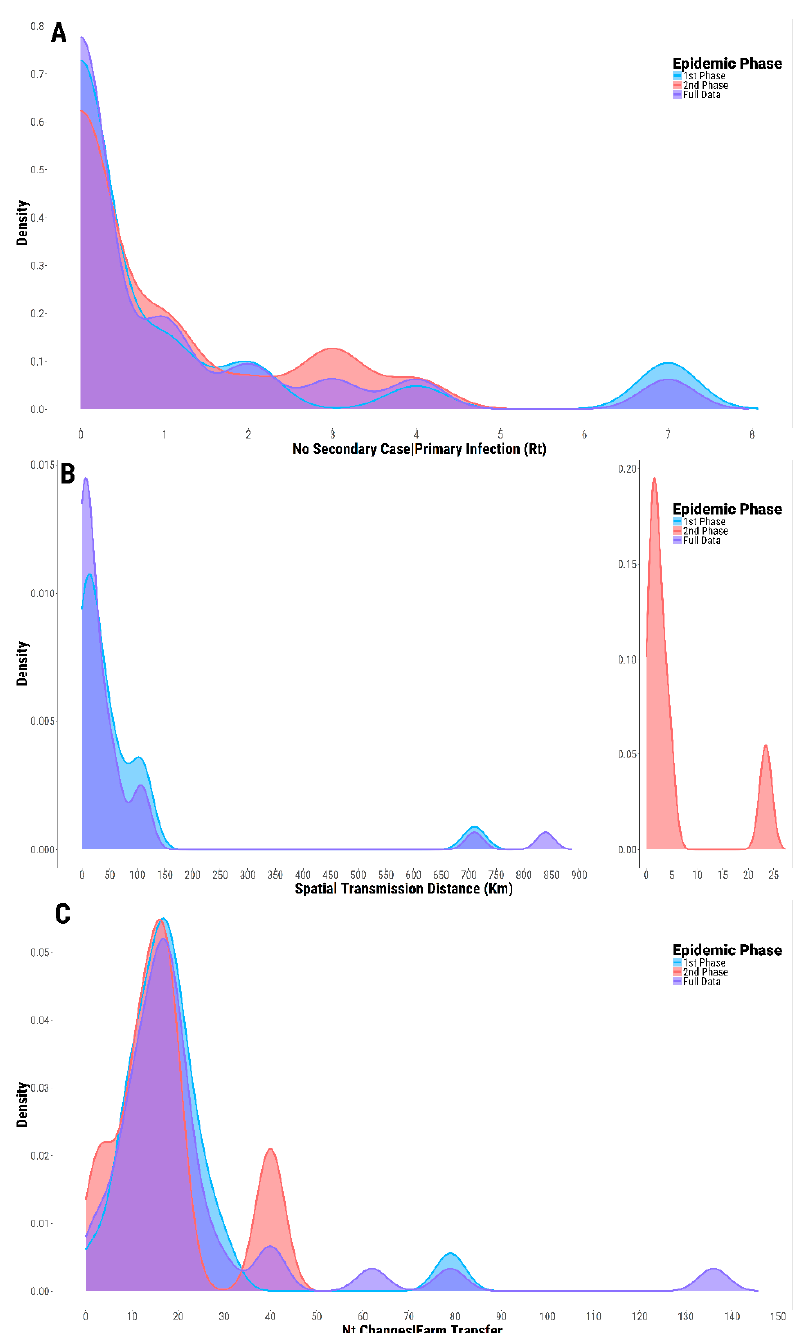
Figure 6. Epidemiological parameters characterising the 2006–2007 SVD epidemic in northern Italy. Kernel density distributions estimated for: the reproduction number R t ( A ); the spatial transmission distances between linked farms ( B ); the nt changes acquired per farm transfer ( C ), respectively, de- rived for the full timeframe of the epidemic (violet), the first (blue), and second (red) epidemic